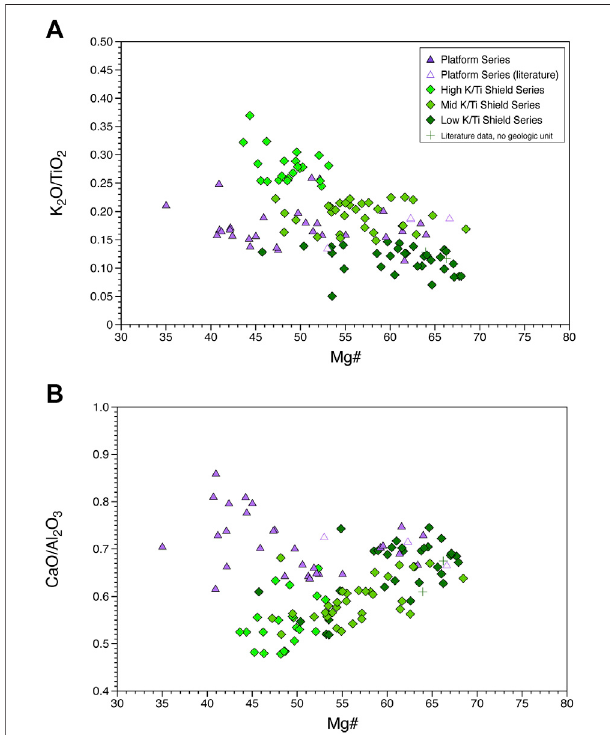
FIGURE 4 | Major element ratio variation with Mg# for Santa Cruz lavas. (A) K 2 O/TiO 2 , to illustrate how Shield Series sub-groups were de fi ned. (B) CaO/Al 2 O 3 . Concentrations are in weight percent (wt.%) and have been normalized to 100%. Symbols are larger than 1 σ analytical error. Samples indicated by a cross are literature data from Santa Cruz (White et al.,